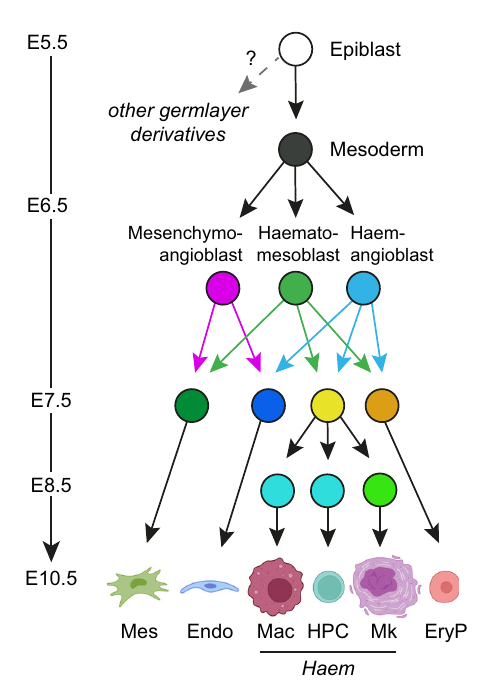
Fig. 7 | Model of mesodermal diversi fi cation in the yolk sac via dual outcome precursors. Endothelial,mesenchymal,andhaematopoieticlineagesintheyolksac aretheproductofmesenchymoangioblast,haemangioblast,orhaematomesoblast differentiation. Created with BioRender.com. EryP (primitive erythroid), Mk (megakaryocyte), HPC (haematopoietic progenitor/colony forming cell),